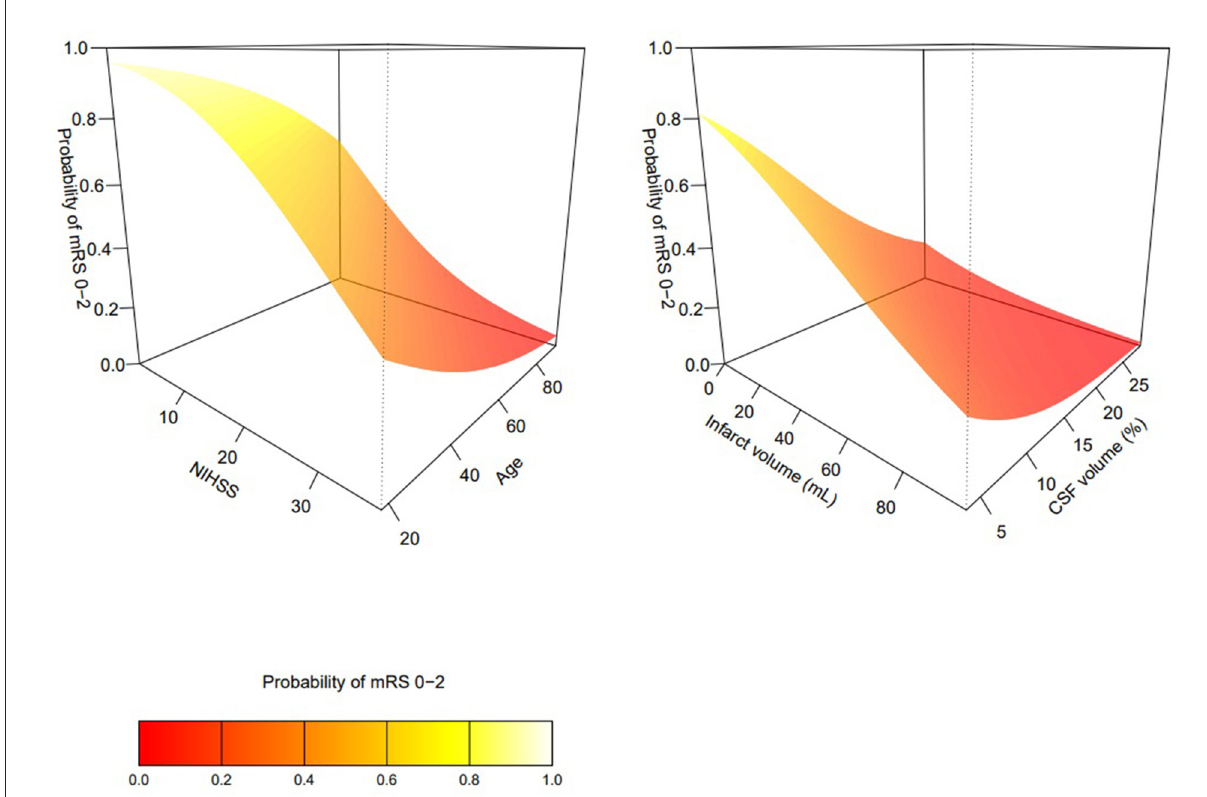
FIGURE1 Interactions between age and NIHSS (left) , and infarct volume and atrophy (right) in predicting mRS 0–2 at 90